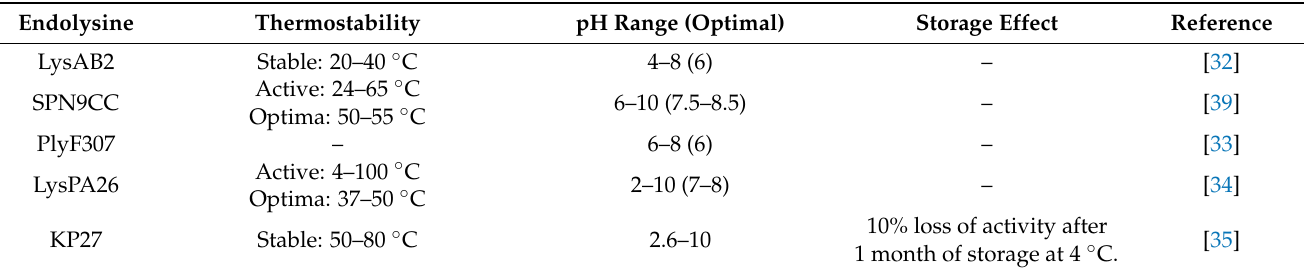
Table 3. Abiotic factors that alter the stability of